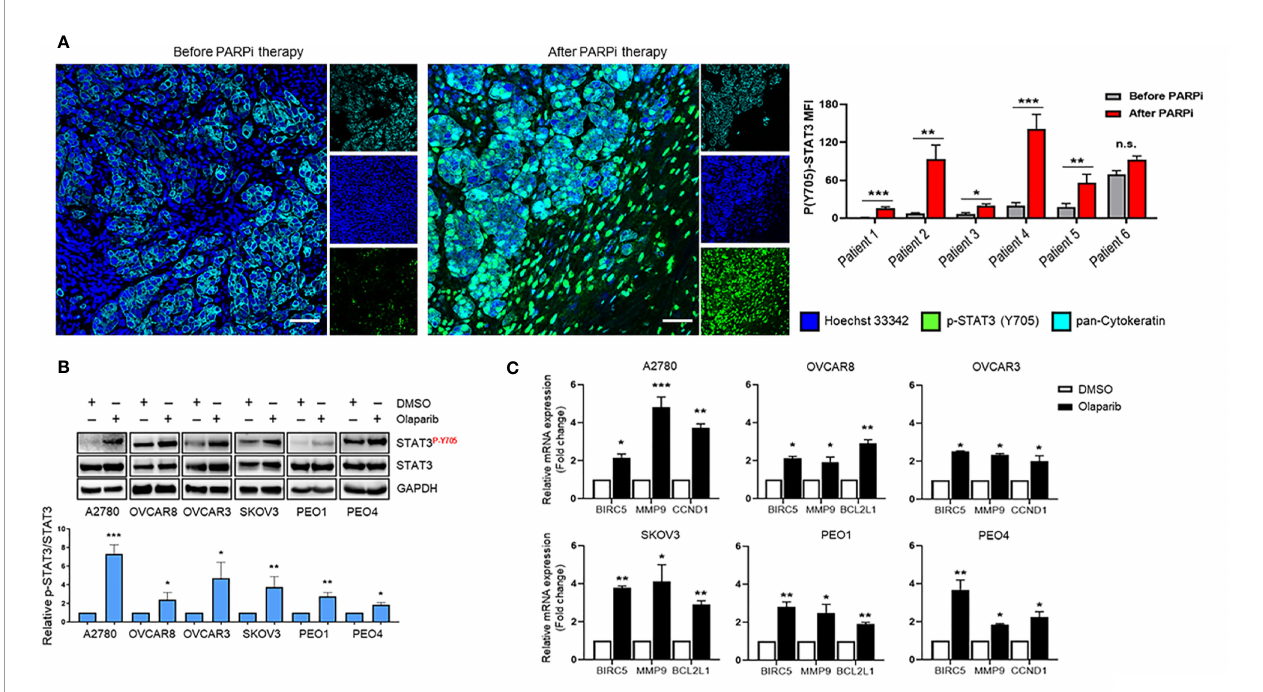
FIGURE 1 | STAT3 phosphorylation is increased in PARPi-treated ovarian cancer patient tumors and cell lines. (A) Representative immuno fl uorescence images (left) from ovarian cancer patients with germline BRCA mutations that were stained for p-STAT3 (green) and pan-Cytokeratin (Cyan), while nuclei were stained with Hoechst (blue). Cytokeratin-stained cell clusters represent malignant tissue. Scale bars = 50 m m. Quanti fi cation of p-STAT3 before and after PARPi therapy in BRCA- mutant ovarian patients (right) was performed using ZEN Lite software, normalized to mean nuclear staining, and relative fold change for each patient was plotted using GraphPad Prism 8. Unpaired two-tailed Student t-test was performed against before controls. Shown are means ± SD (n = 9 per sample). *p<0.05, **p<0.01, and ***p<0.001. (B) Western blot measuring activated (P-Y705) and total STAT3 levels in A2780, OVCAR8, OVCAR3, SKOV3, PEO1, and PEO4 ovarian cancer cell lines after treatment with 0.1% DMSO or different concentrations of Olaparib (OVCAR3 and PEO1 were treated with 5 µM, A2780 and OVCAR8 with 10 µM, SKOV3 and PEO4 with 20 µ) for 24 h (top). GAPDH immunostaining served as a loading control. Relative band intensities from three independent experiments were quanti fi ed using ImageJ software and means are shown ± SD (bottom). Unpaired two-tailed Student t-test of Olaparib treated cells performed against vehicle controls. *p<0.05, **p<0.01, and ***p<0.001. (C) Real-time PCR measuring STAT3 target gene BIRC5, MMP9, CCND1 , and BCL2L1 mRNA levels in A2780, OVCAR8, OVCAR3, SKOV3, PEO1, and PEO4 ovarian cancer cell lines treated either with DMSO or different concentrations of Olaparib (OVCAR3 and PEO1 were treated with 5 µM, A2780 and OVCAR8 with 10 µM, SKOV3 and PEO4 with 20 µM) for 48 h. Gene expression was normalized to the housekeeper gene ACTB and relative expressions against vehicle controls are shown. Unpaired two-tailed Student t-test of Olaparib treated cells performed against DMSO controls. Shown are means ± SD. *p<0.05, **p<0.01, and ***p<0.001, n.s., not signi fi